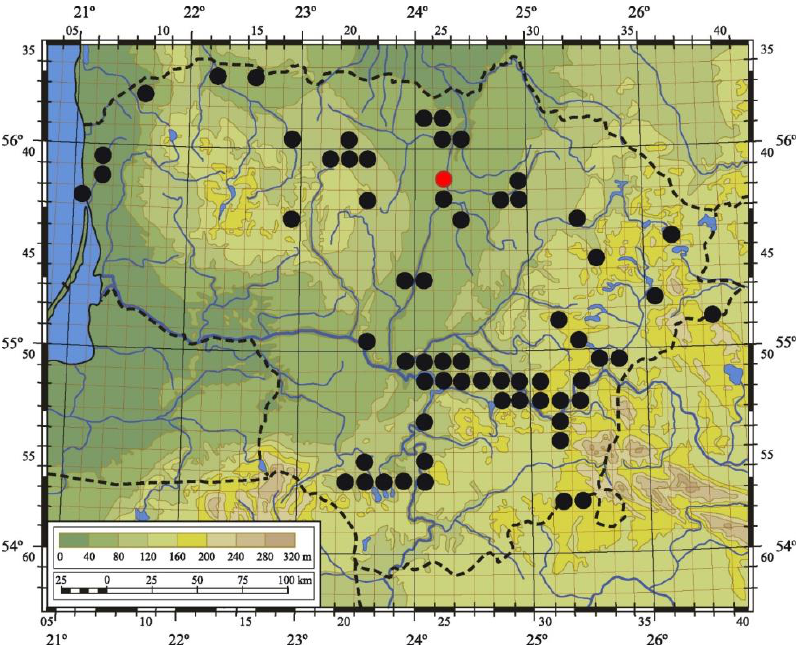
Figure 2. The current distribution of Cornus sanguinea subsp. australis in Lithuania. The red dot marks the first record of this taxon in Lithuania; the black dots mark localities based on the results of this research.